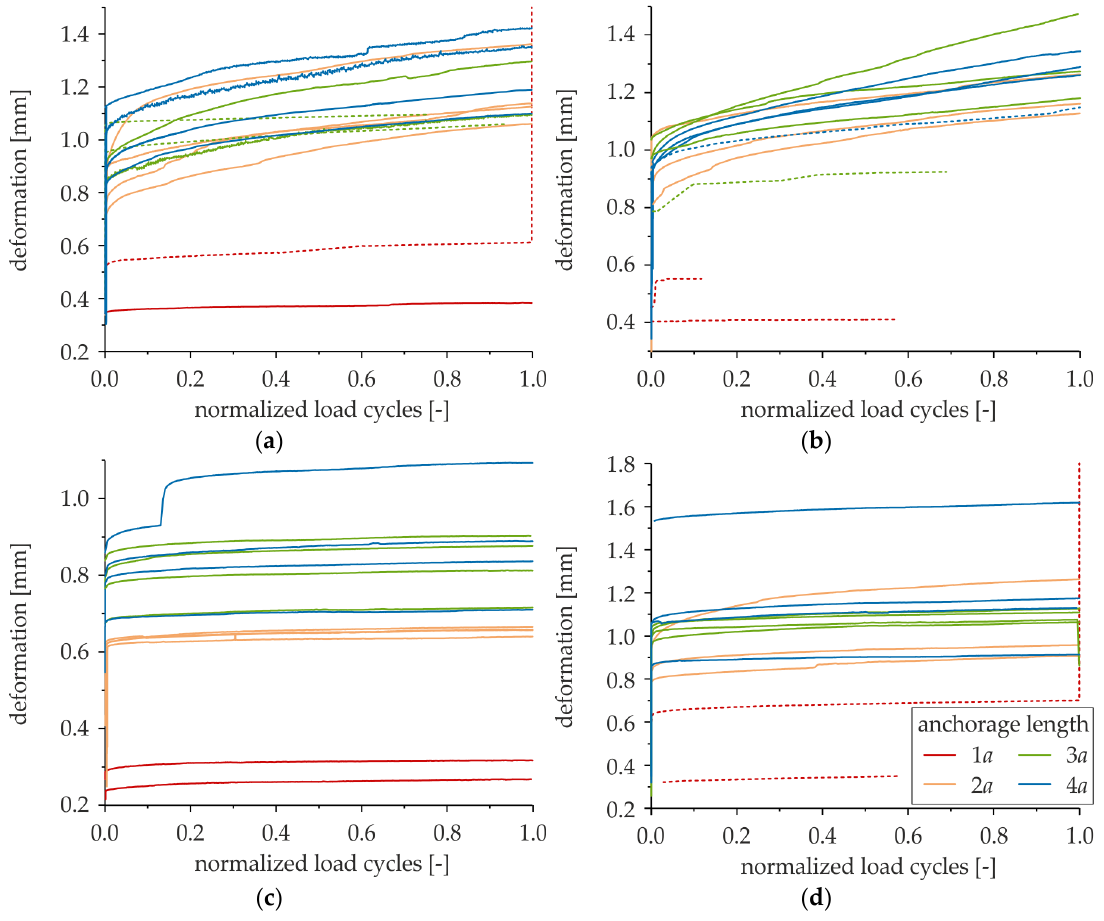
Figure A5. Comparison of normalized cyclic creep curves depending on the anchorage length: ( a ) σ min / σ max = 30%/90%; ( b ) σ min / σ max = 30%/95%; ( c ) σ min / σ max = 50%/70%; and ( d ) σ min / σ max = 50%/90%.